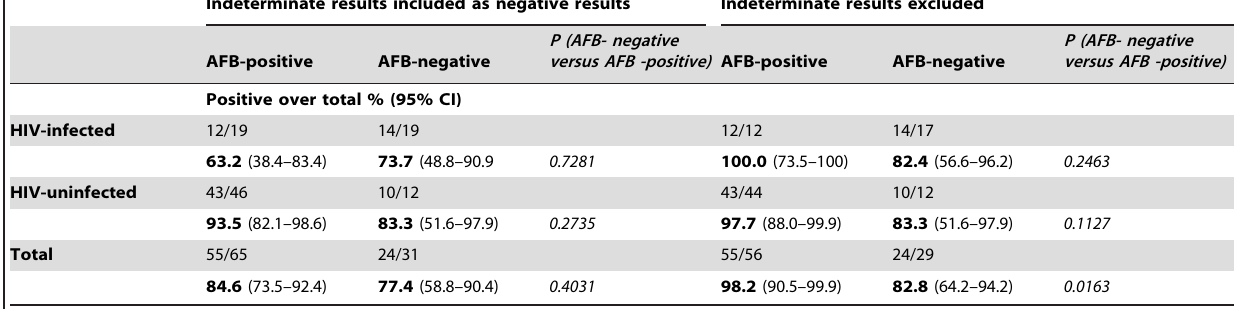
Table 6. Sensitivity of QFT-GIT calculated over the total of patients tested (indeterminate results included as negative results) and only over the interpretable results (indeterminate results excluded) in PTB patients stratified by HIV status according to smear microscopy